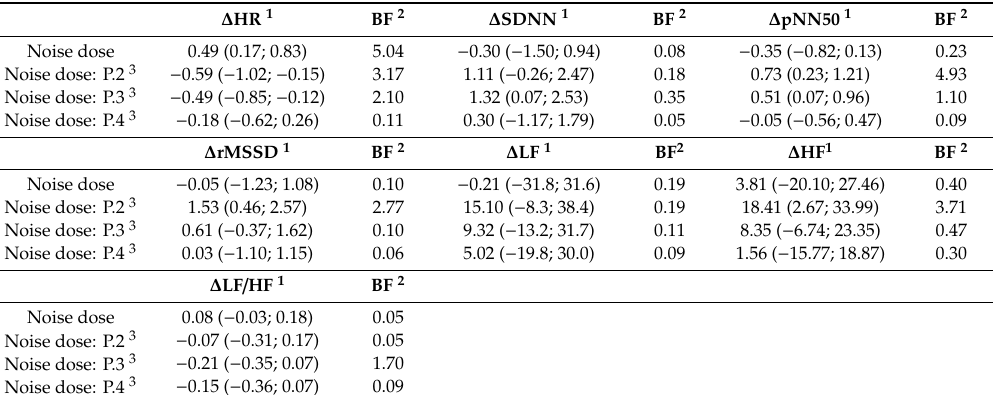
Table 6. E ff ects of total noise dose exposure on ECG parameters variability 1